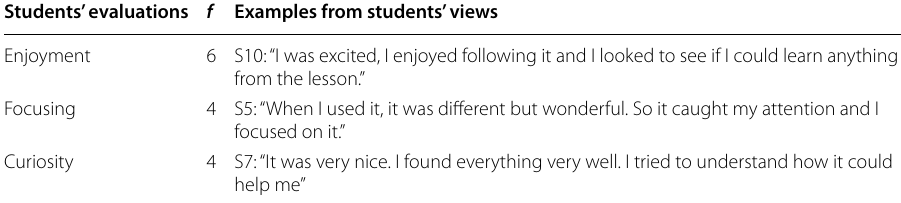
Table 3 Student feelings when using AR application